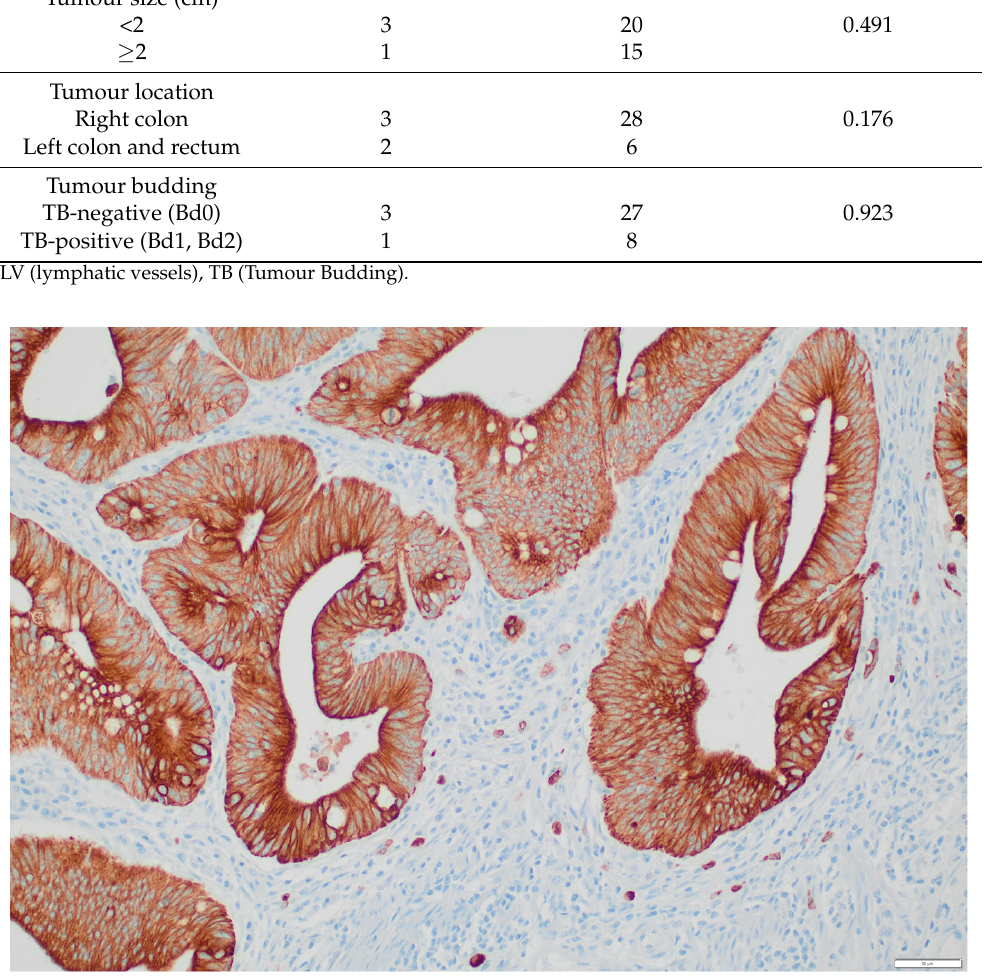
Table 3. Characteristics of pTis colorectal carcinomas according to OSNA results.